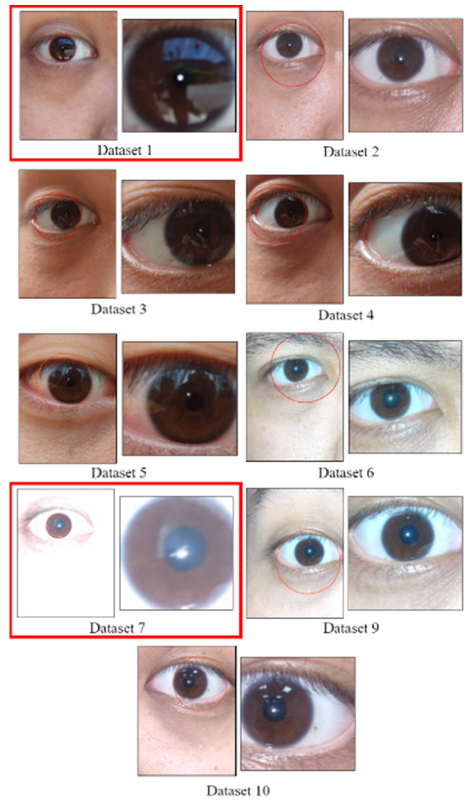
Figure 50. Results of the Hough circle test for each data set.